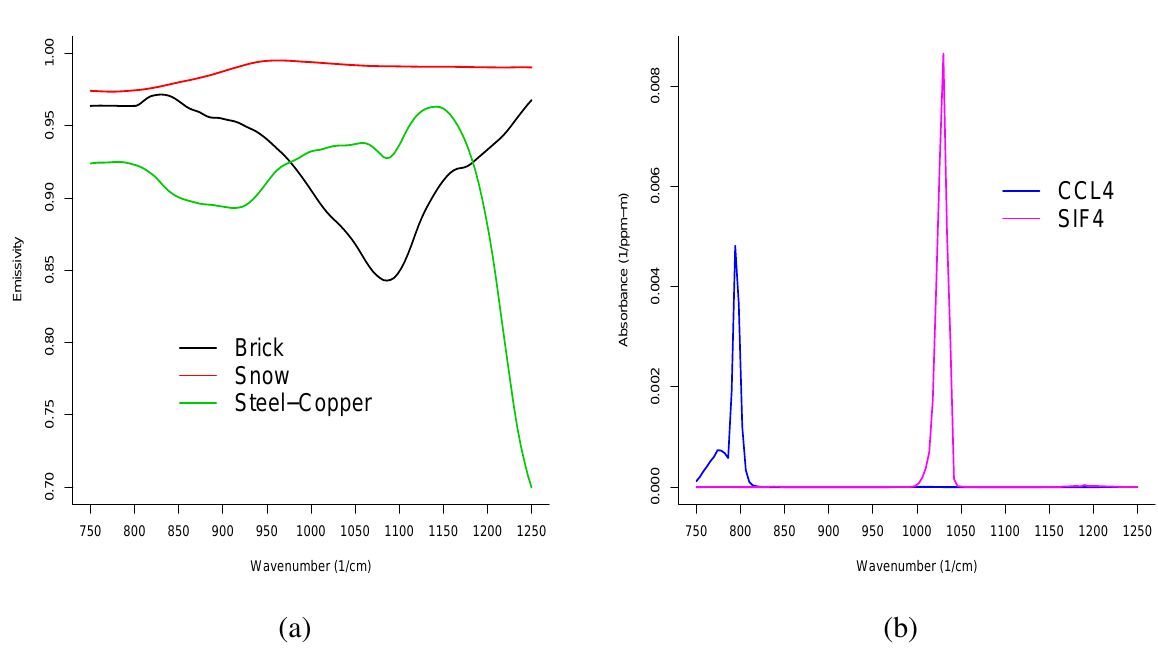
Figure 2. (a) Background emissivity spectra used in image simulation. (b) Chemical Ab- sorbance spectra used in image